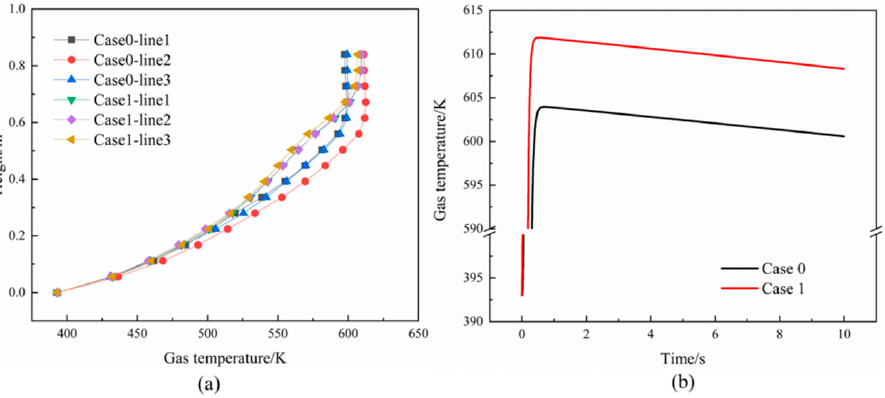
Figure 6. Cooling gas temperature distribution on line 1~3 and outlet cooling gas temperature. ( a ) ( a ) Gas temperature distribution; ( b ) outlet cooling gas Gas temperature distribution; ( b ) outlet cooling gas temperature.